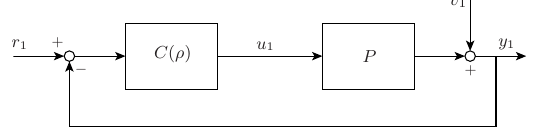
Figure 1. Block diagram of a closed-loop system.